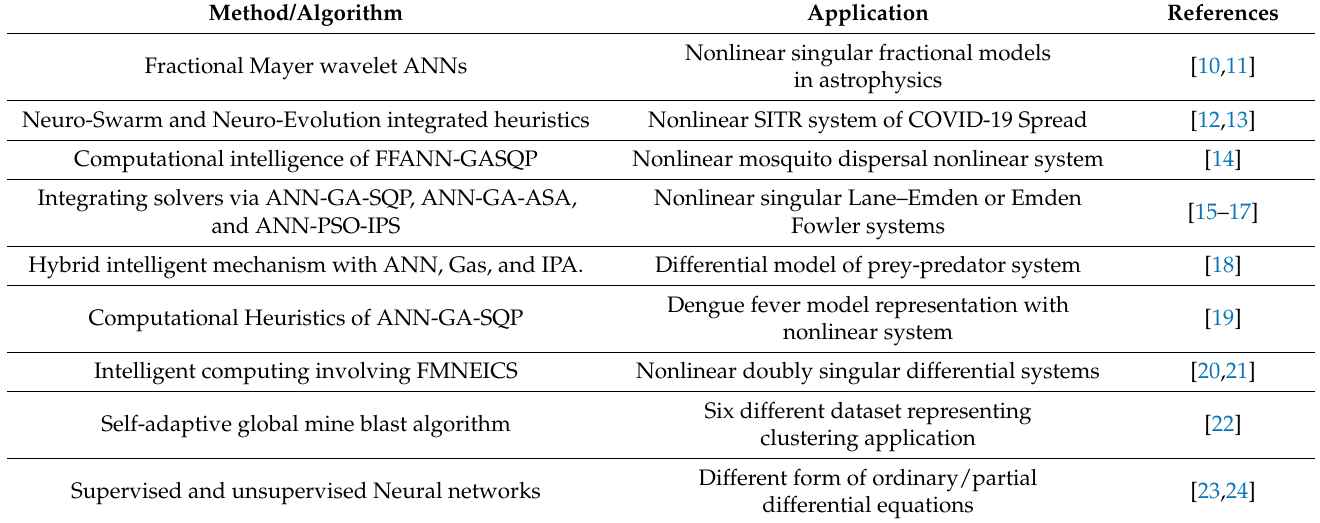
Table 1. A brief literature review of the stochastic numerical solver application in a variety of